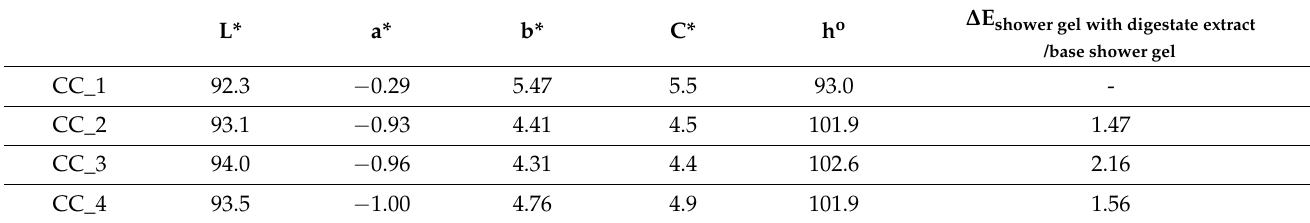
Table 3. Color parameters for cosmetic (shower gel).